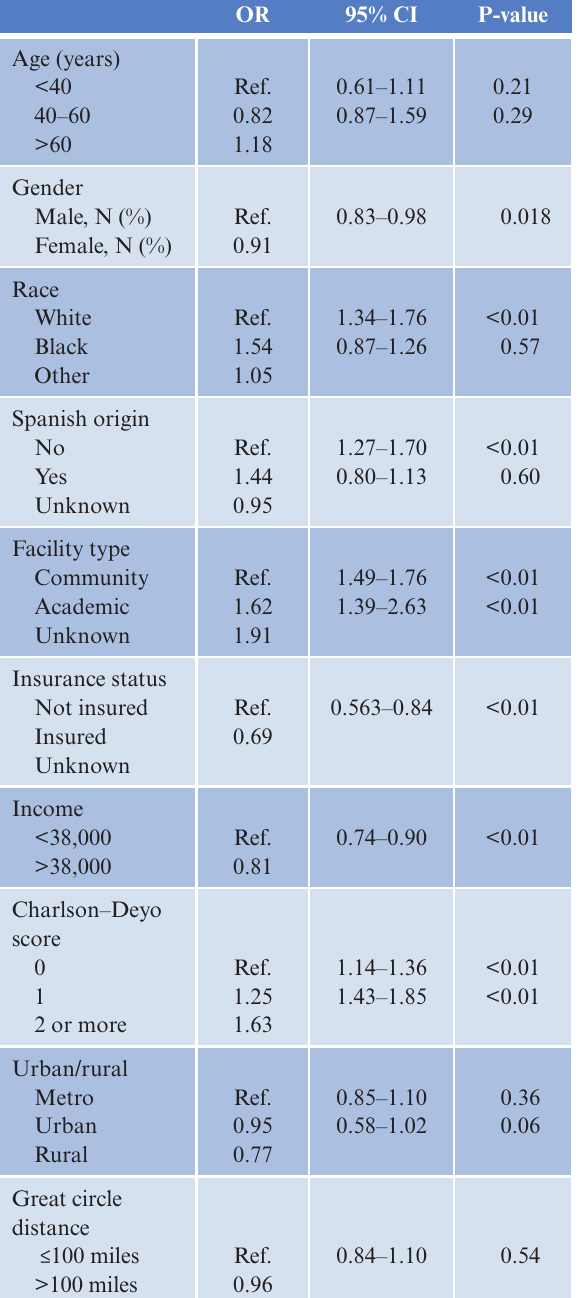
Table 3: Logistic regression analysis for surgical wait time (SWT) > 10 weeks .